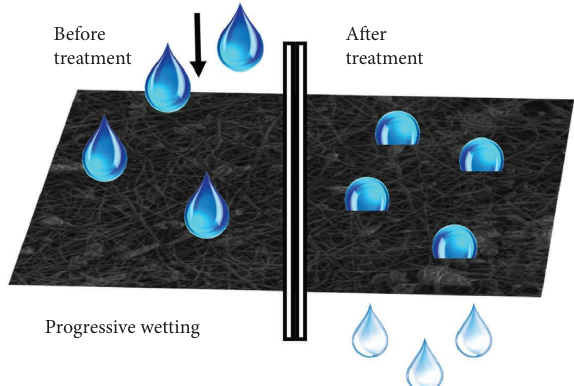
Figure 11: Illustration of the progressive wetting of methylene blue dye molecules onto a PVB/bentonite nanofber mat.